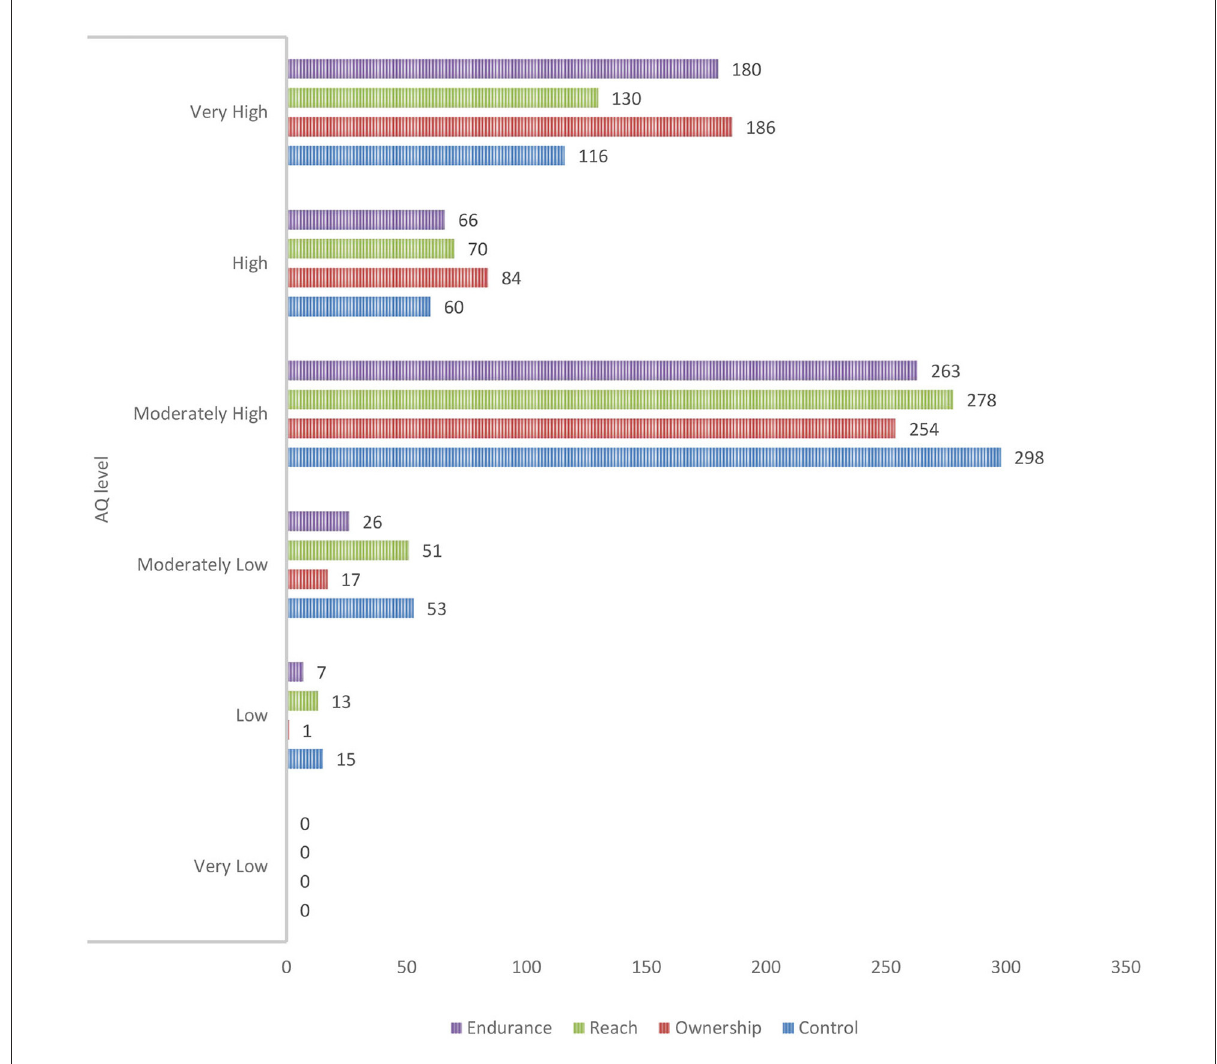
FIGURE1 AQ levels of pre-service teachers for all the AQ